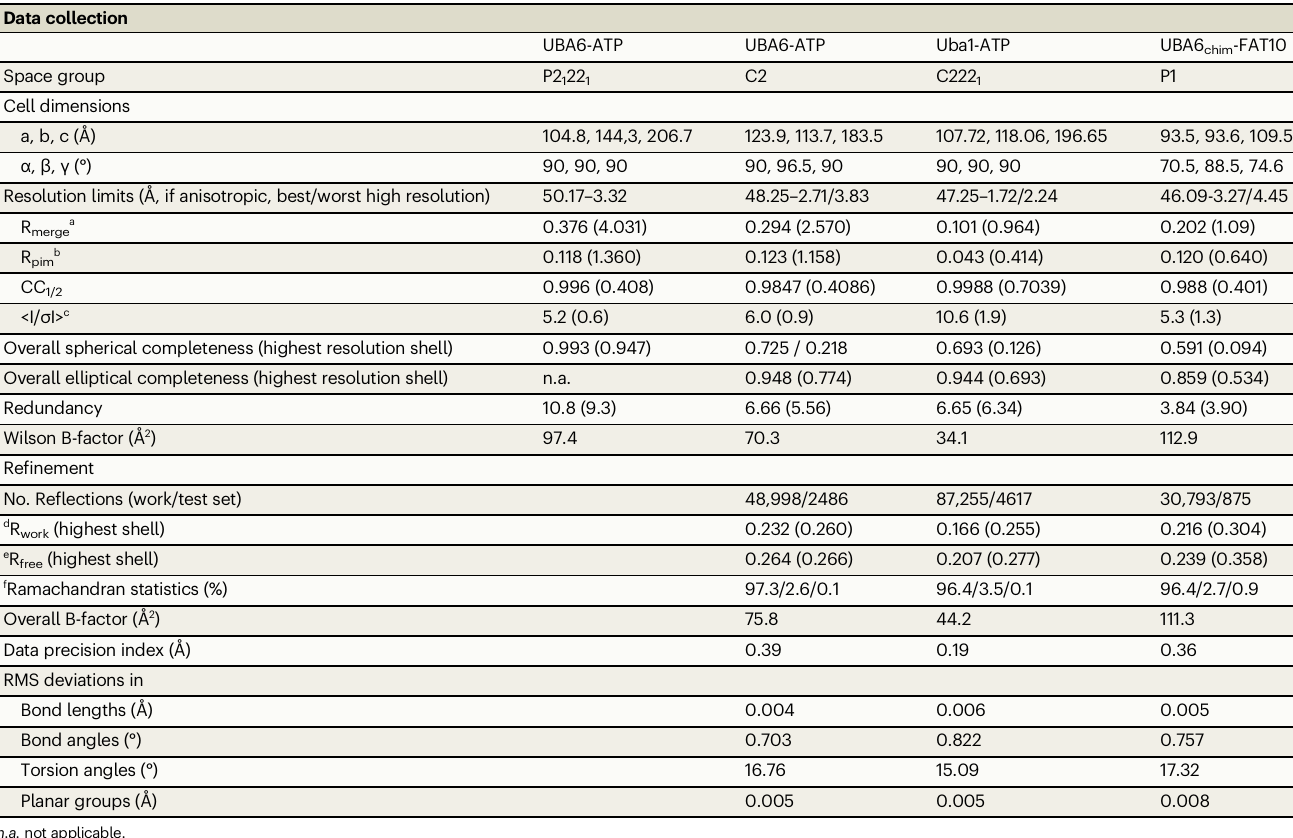
Table 1 | Data collection statistics and re fi nement